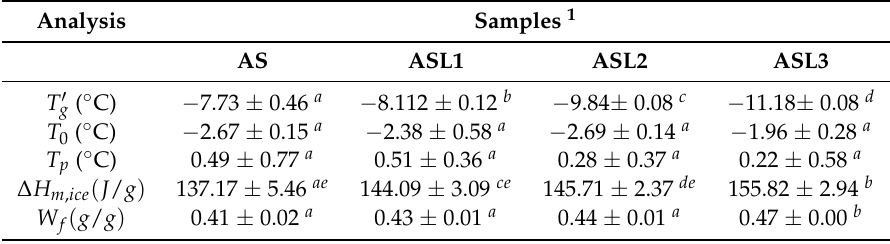
Table 3. Effect of the lauroylation on the ice melting properties determined by DSC. Analysis